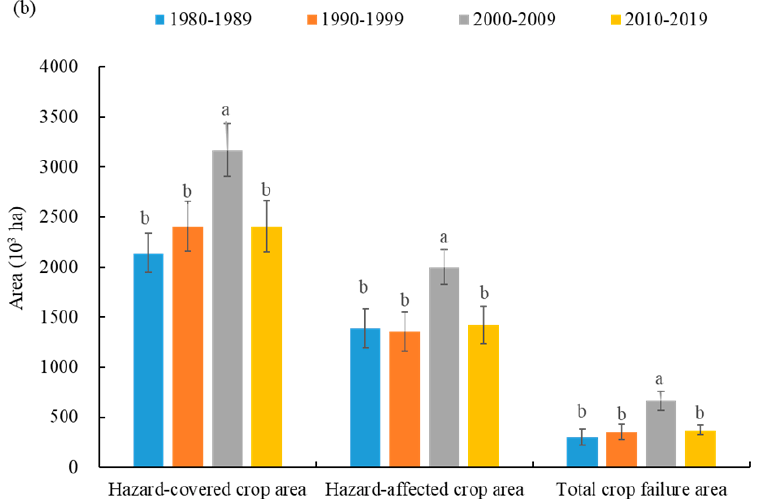
Figure 7. Disaster-covered, disaster-affected, and disaster-damaged area in the whole country and Inner Mongolia Autonomous Region from 1980 to 2019. Note: ( a , b ) are disaster-covered, disaster-affected, and disaster-damaged area in the whole country and Inner Mongolia Autonomous Region, respectively. Different letters between different time periods represent significant differences at p < 0.05.